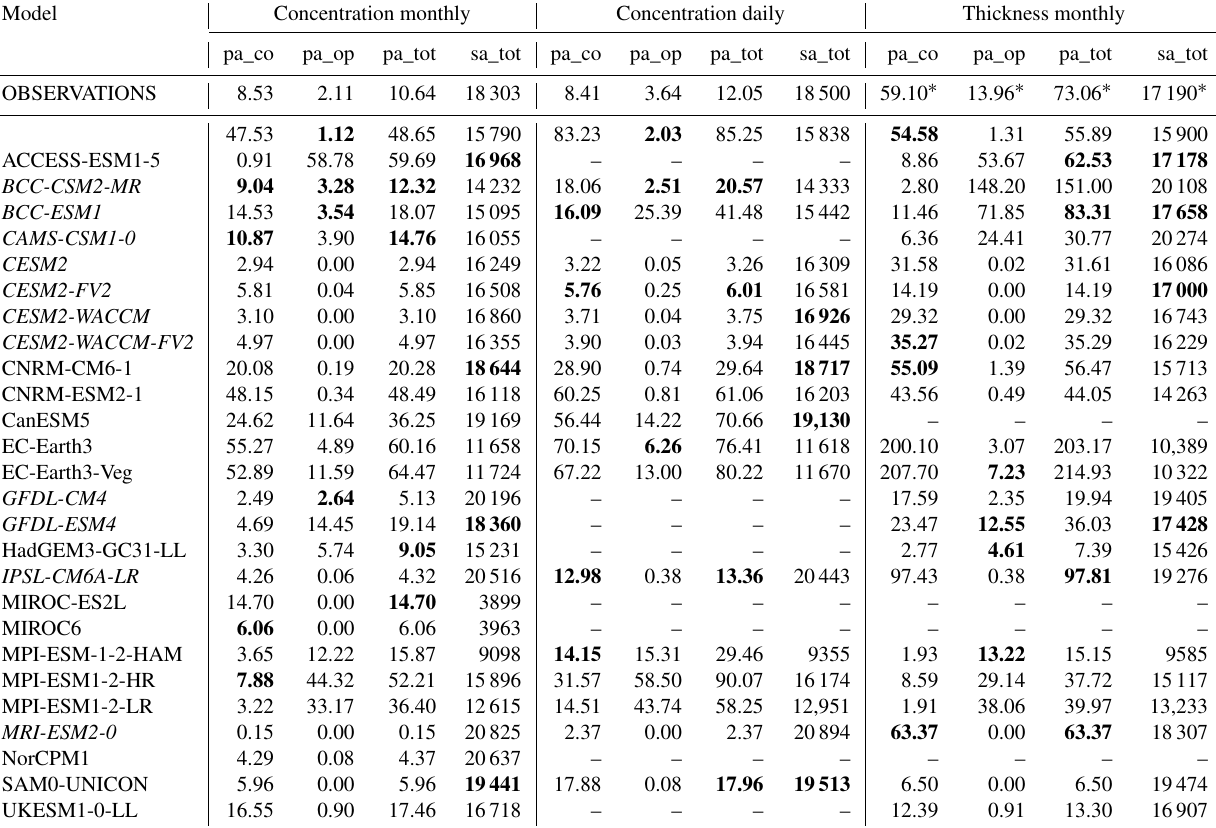
Table 2. Mean yearly areas of coastal polynyas (pa_co), OWPs (pa_op), their sum (pa_tot) and the maximum sea ice area (sa_tot) in 10 3 km 2 derived from monthly/daily sea ice concentration and monthly sea ice thickness for September for the complete Southern Ocean, averaged over 1979–2015. Observational sea ice thickness marked with an asterisk ( ∗ ) is available over a 10-year period only. The four models matching the observations closest are printed in bold, and italic models have a an r value less than 0.8 (Figs. A1 and A2) and thus a relatively weak consistency over the three used sea ice